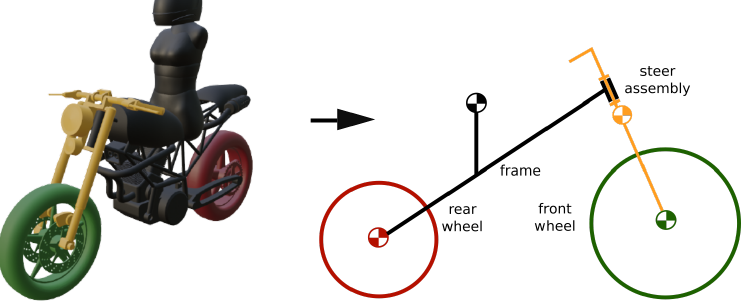
Figure 3. Multibody model transform to Whipple’s